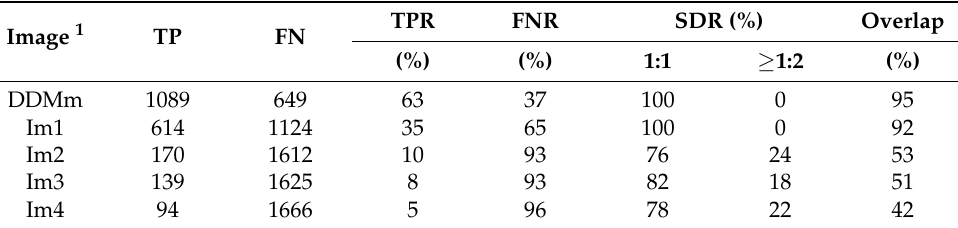
Table 1. Contingency table for object counting with density-, area- and connectivity-based approach.